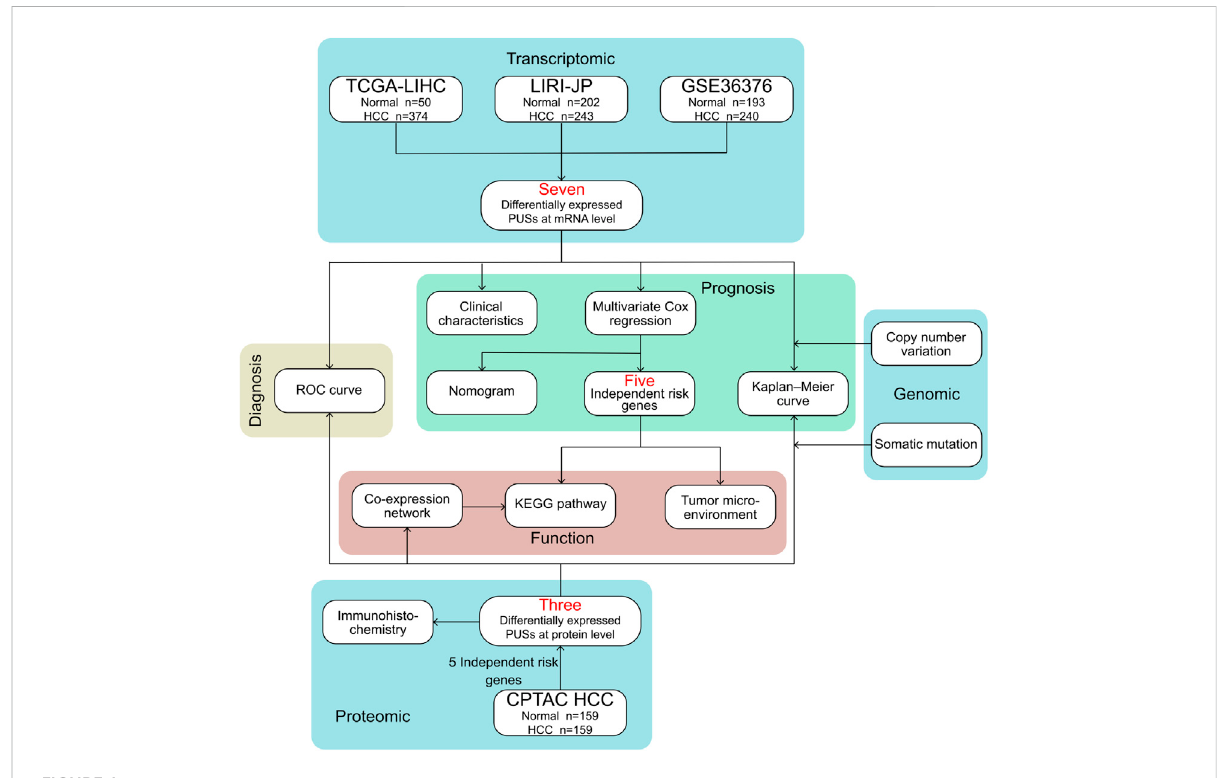
FIGURE 1 Flowchart of the present